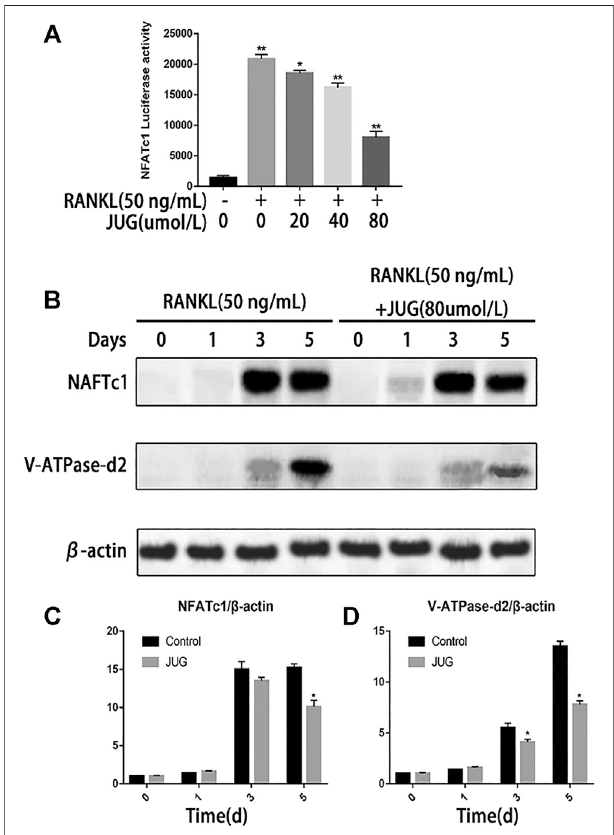
FIGURE 5 | JUG suppresses NFATc1 activity and down-regulates the expression of related protein. (A) luciferase reporter gene assay was performed to detect transcriptional activity of NFATc1. (B) Representative images of western blots demonstrating the effect of JUG on the expression of NFATc1 and related proteins V-ATPase d2, induced by RANKL ontheindicateddays. (C,D) Relativeresultswereexpressedbytheratioofthe amount ofNFATc1 and related proteins V-ATPase d2 determined byimage J. Data are presented as the mean ± SEM, * p < 0.05, ** p < 0.01. n (cid:2) 3